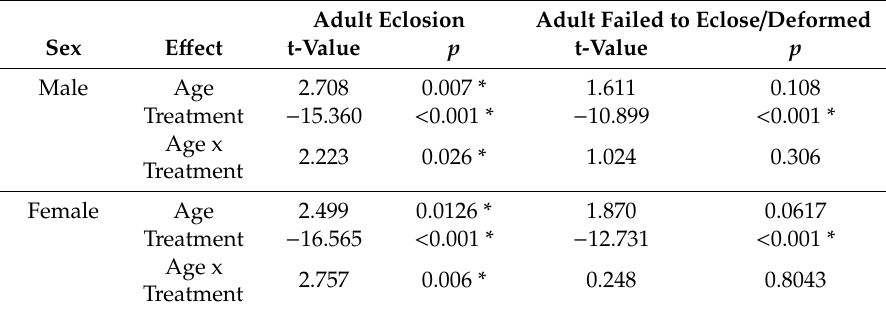
Table 2. Main e ff ects of tebufenozide dosage (% ACI) and pupal age at treatment on likelihood of the adult eclosion of a normal adult and likelihood of pupal death / adult eclosion with a deformity in C.